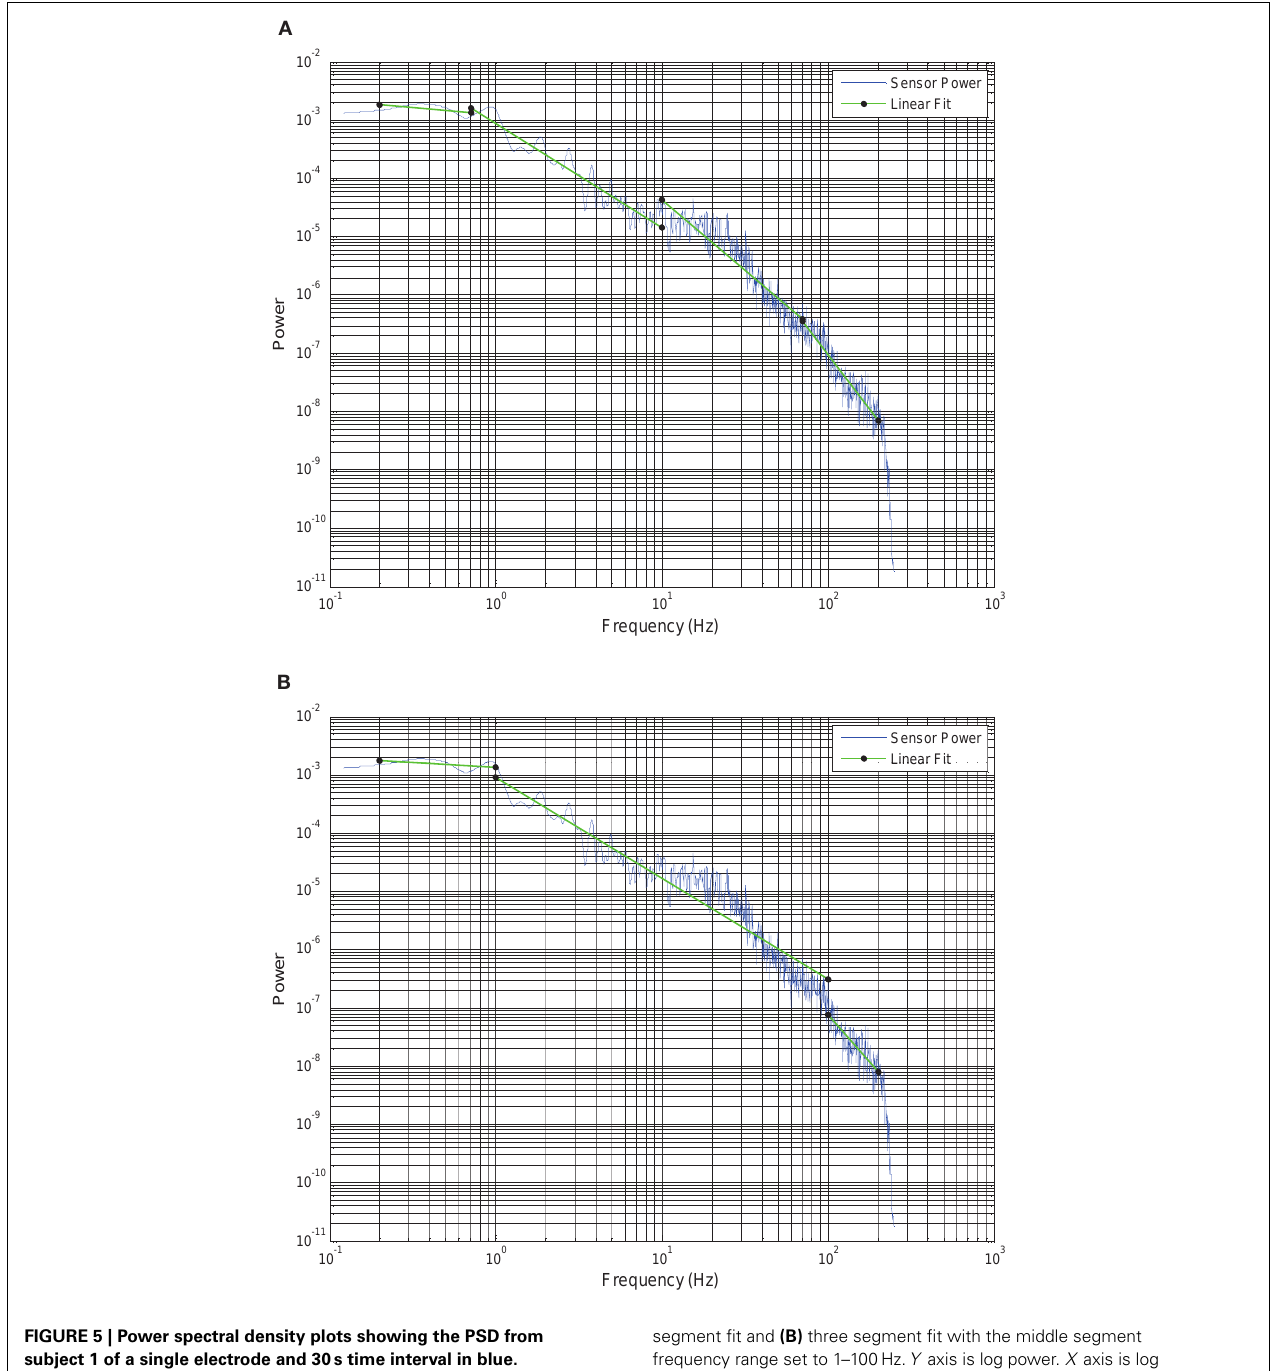
FIGURE 5 | Powerspectral density plots showing the PSD from subject 1 of a single electrode and 30s time interval in blue. Green lines with endpoints show the (A) least error four slope